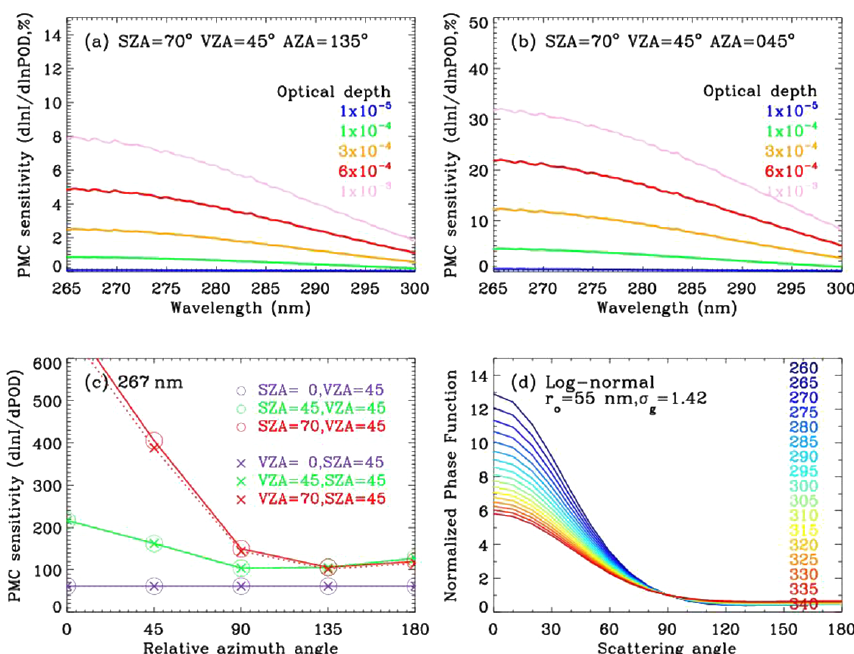
Figure 5. (a) The sensitivity of normalized radiance to five POD values ranging from 10 − 5 to 10 − 3 as functions of wavelength at SZA = 70 ◦ , VZA = 45 ◦ , and AZA = 135 ◦ . (b) Same as (a) but for AZA = 45 ◦ . (c) The sensitivity of normalized radiance to the unit of POD as a function of AZA with various SZAs and VZAs at 267nm. (d) PMC phase function as a function of scattering angle ( (cid:56) ) for wavelengths ranging from 260 to 340nm, normalized to unity at (cid:56) = 90 ◦ .